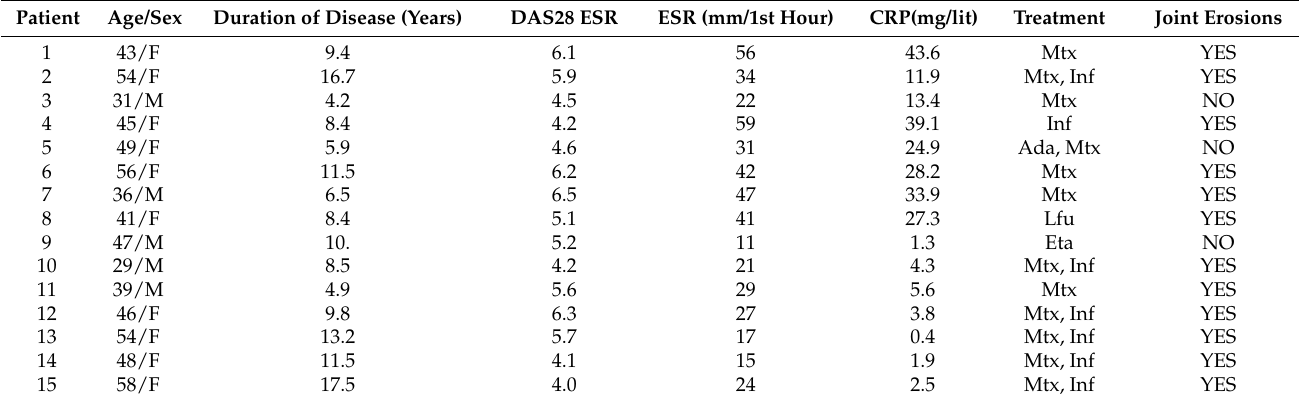
Table 1. Characteristics of rheumatoid arthritis patients included in the study.